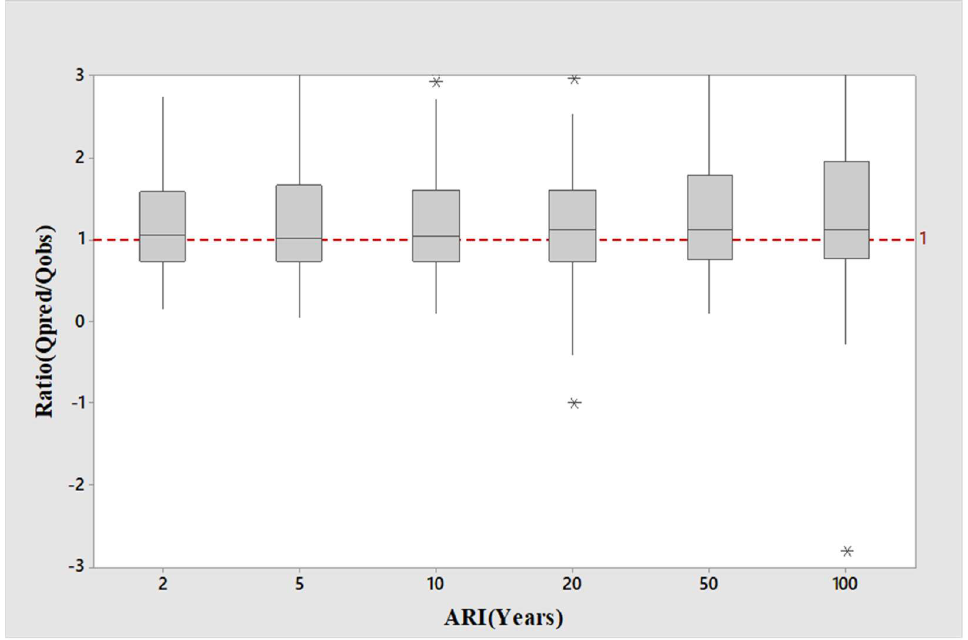
Figure 5. Boxplots of Q pred / Q obs ratio values for GAM model of combined group (* represents outliers).